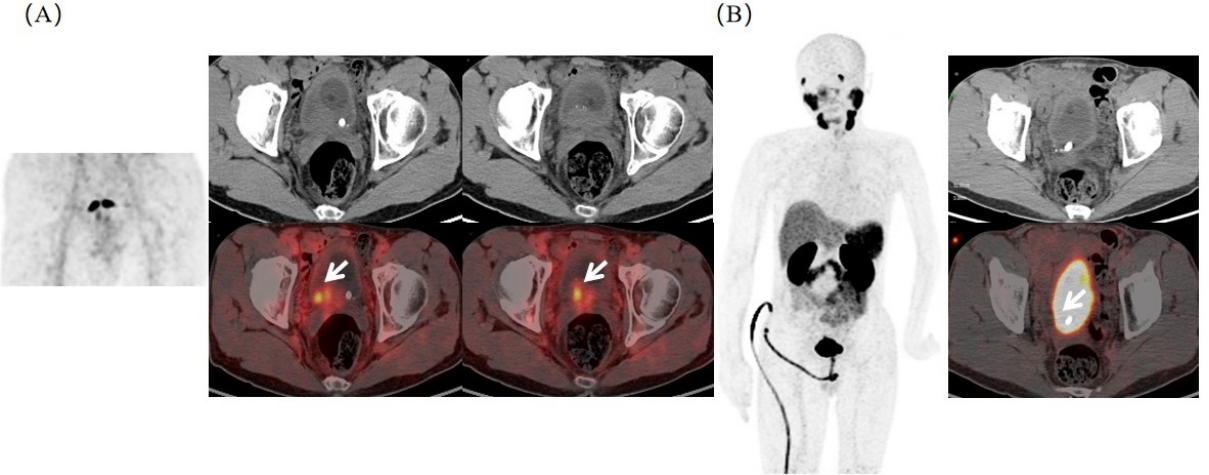
Figure 4. 68 Ga-PSMA-11 PET/CT in a 65-year-old PCa patient after endocrine therapy with elevated tPSA (42.18 ng/mL). ( A ) Focal increased 68 Ga-PSMA-11 uptake (SUV max = 22.7, T/BL ratio = 15.1) on the posterior wall of the bladder on fused axial PET/CT at 3 min P.I. (white arrow). ( B ) Corresponding bladder images at 45 min P.I., with markedly increased tracer accumulation. Differentiation of lesions and physiologic urethra activity was not possible.